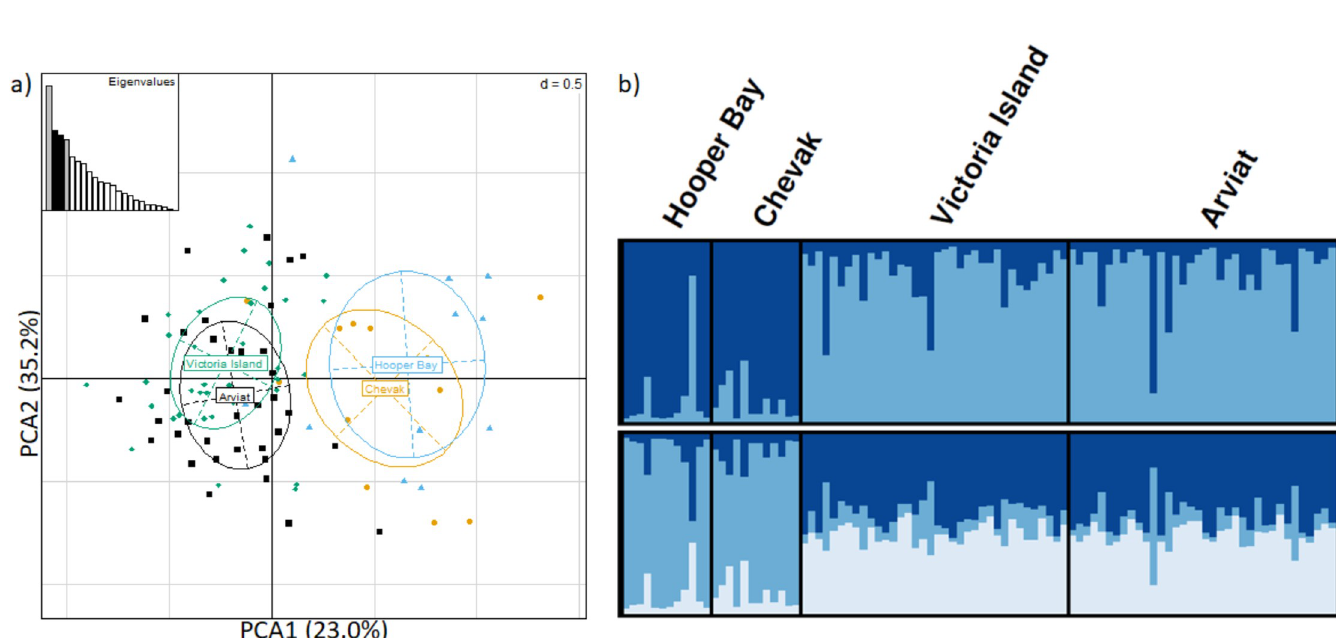
Fig 2. Neutral genetic homogeneity of arctic fox across North America. Analyses of the 29 presumed neutral SNPs after filtering with Variant Effect Predictor, MAF = 2.5%, and pruning for Linkage disequilibrium A) principle component analysis B) STRUCTURE analysis of K = 2 and 3 (top and bottom respectively), where each bar across horizontal axis indicates an individual, vertical axis depicts cluster assignment, and different colors depict each genetic cluster; Arviat = black square; Chevak = yellow circle; Hooper Bay = blue triangle; Victoria Island = green diamond.